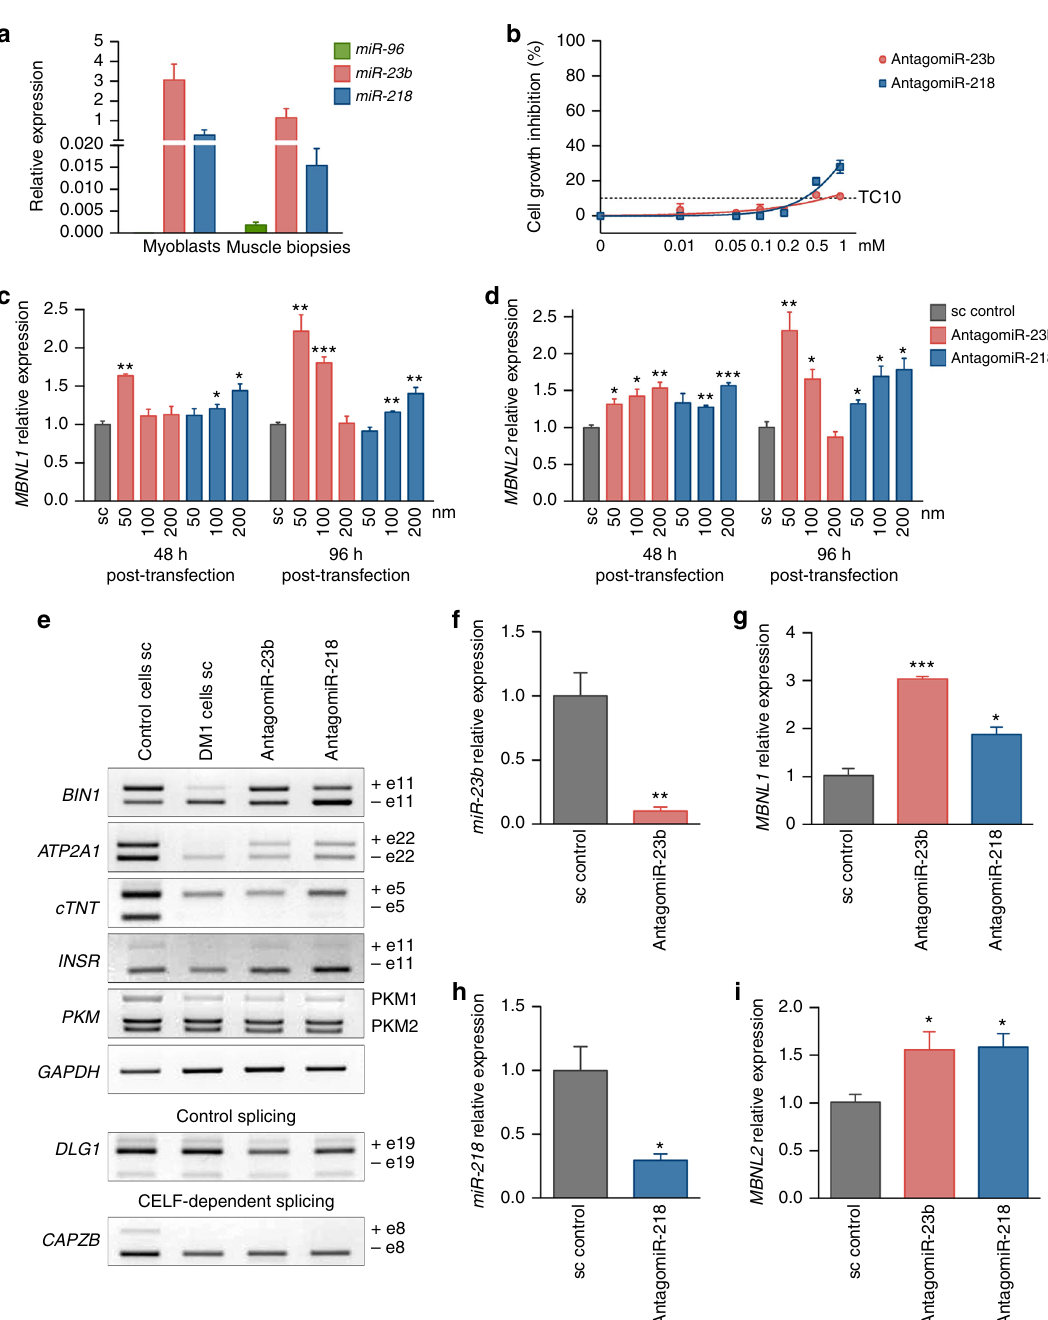
Fig. 3 AntagomiR-23b and -218 stabilize MBNL transcripts and rescue alternative splicing defects in DM1 myoblasts. a Real-time PCR quanti fi cation of miR- 96 , miR-23b , and miR-218 expression in myoblasts and muscle biopsies from DM1 patients. U1 and U6 snRNAs were used as reference genes. b Cell growth inhibition assay by MTS method. Human normal myoblasts were transfected with increasing concentrations of antagomiRs against miR-23b and miR-218 ( n = 4). TC10 was obtained using the least squares non-linear regression model. c , d qRT-PCR quanti fi cation of MBNL1 ( c ) and MBNL2 ( d ) expression relative to GAPDH and ACTB genes in human DM1 myoblasts transfected with the indicated antagomiRs or scrambled control antagomiR (sc). e Semiquantitative RT-PCR analyses of splicing events altered in BIN1 (exon 11), ATP2A1 (exon 22), cTNT (exon 5), INR (exon 11), and PKM isoforms in DM1 cells. GAPDH was used as internal control. Inclusion of DLG1 exon 9, which is not altered in DM1, and CAPZB exon 8, which is CELF1-dependent, were used as additional controls. f , h miRNA real-time PCR determination of available miR-23b ( f ) or miR-218 ( h ) in DM1 myoblasts 96 h after transfection with 50 nM of antagomiR-23b or 200 nM of antagomiR-218. U1 and U6 snRNAs were used as reference genes in f and h . g , i qRT-PCR analyses of MBNL1 ( g ) and MBNL2 ( i ) expression relative to GAPDH and ACTB genes in human myoblasts 96 h after transfection with 50 nM of antagomiR-23b or 200 nM of antagomiR-218. ( n = 3). Data are mean ± SEM. * p < 0.05, ** p < 0.01, *** p < 0.001 according to Student ’ s t